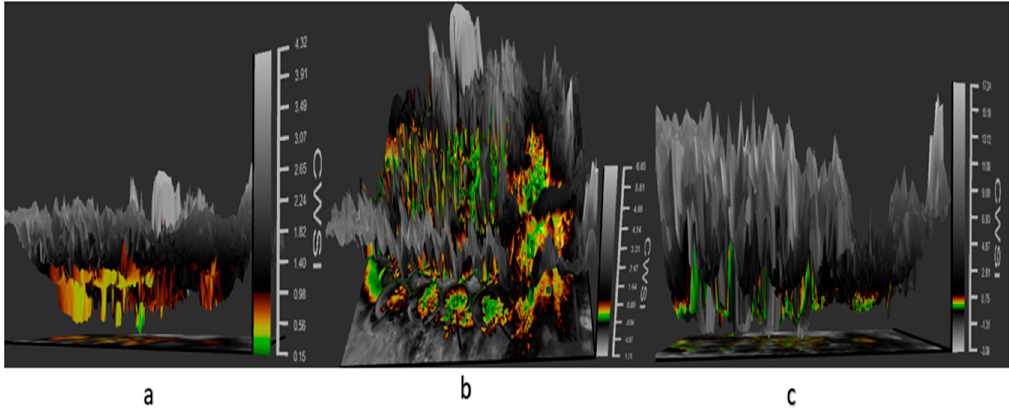
Figure 6. Image colors and corresponding CWSI values at different field capacities in tomato growths.